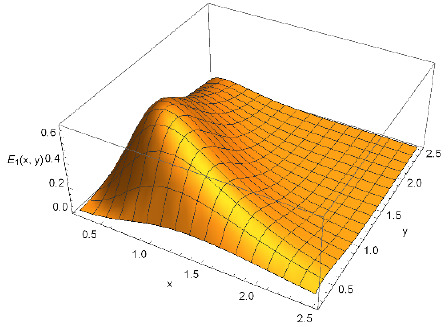
Figure 3 . The form of the function E (cid:27) ( x; y